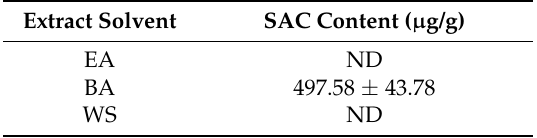
Table 1. SAC content ( µ g/g dry weight) of EA, BA and WS fractions. Extract